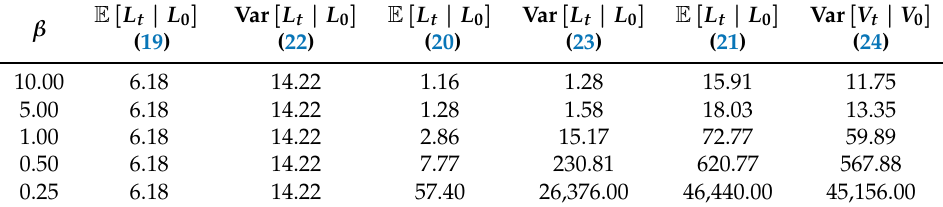
Table 4. Sensitivity analysis of means and variances for the parameter β